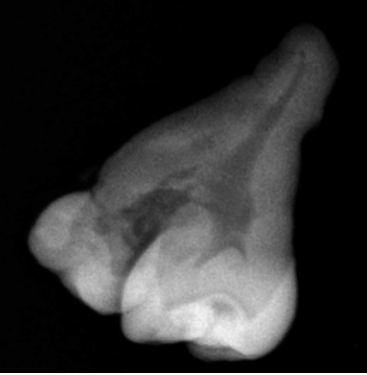
Figure 6. Case 7 (tab. 1). Radiograph of removed geminated tooth